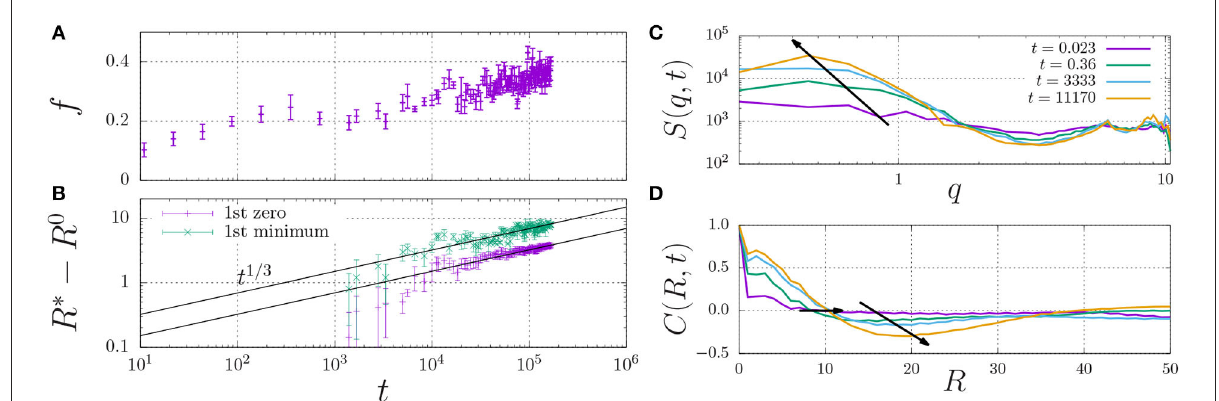
FIGURE5 R 0 (B) against time. The characteristic length scale, R * is determined by Fraction of dimerised material, f , (A) and characteristic length scale, R * − i) calculating the dynamic structure factor, S ( q ) (C) , ii) taking the inverse Fourier transform to obtain the radial correlation function, C ( R , t ) (D) , and iii) determining its first root C 0 (here, we use the initial offset R 0 8) and first minimum for which C < 0 (here, R 0 = = indicate the time dependence of the dominant wavenumber q (C) and the two measures for R * (D)